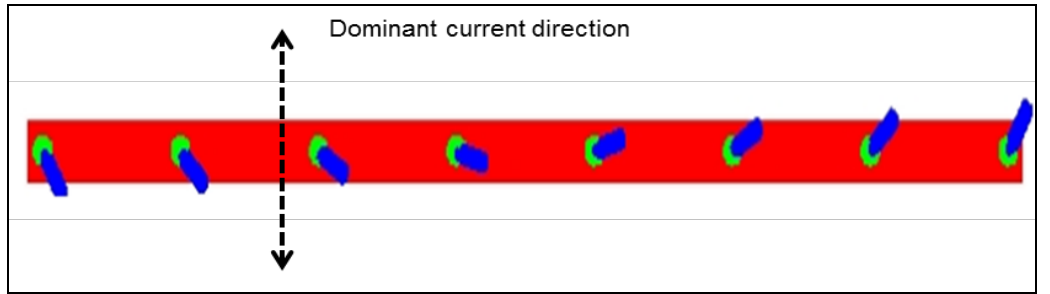
Figure 5. Schematic of staged fan